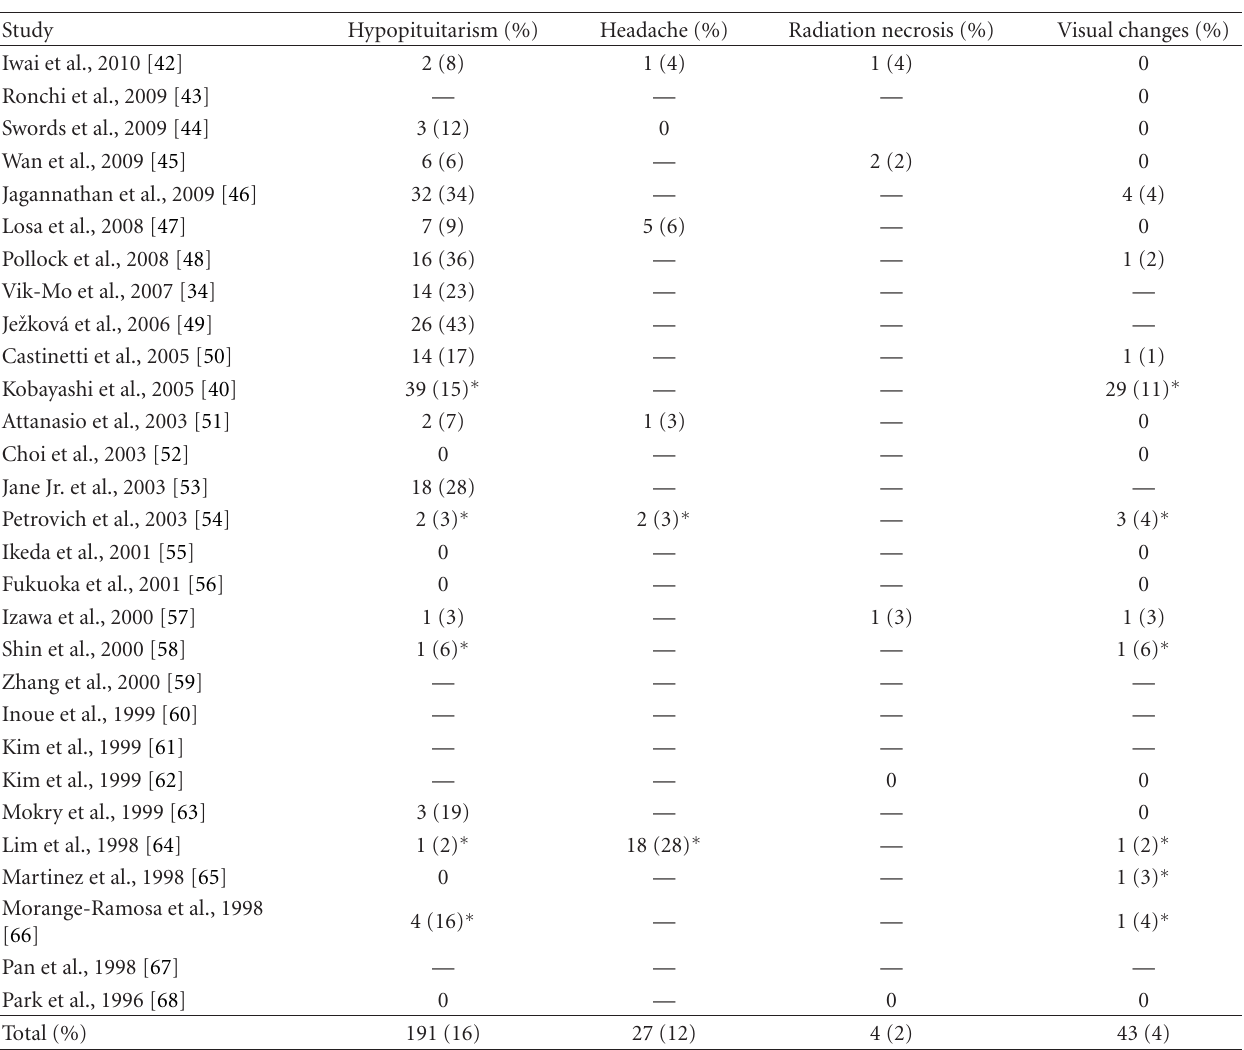
Table 2: Adverse events of GKS for